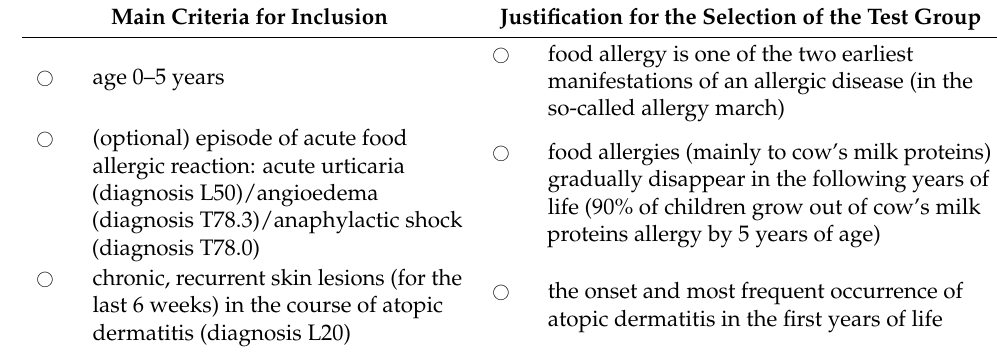
Table 2. Presentation of the main criteria for the inclusion of participants in the study and the justification for the selection of the research group (children 0–5 years